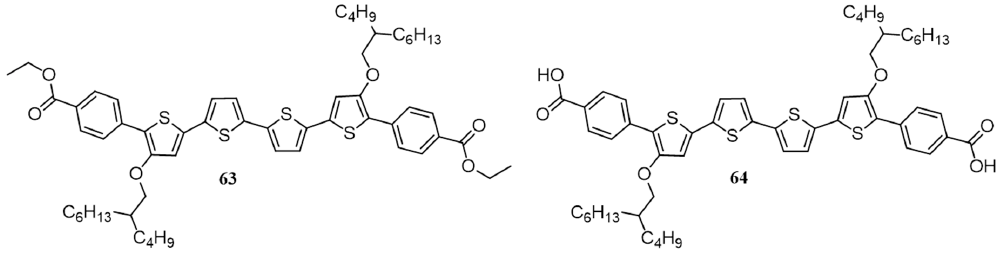
Figure 24. Chemical structures of the quarterthiophene core with diester ( 63 ) and diacid ( 64 ) end-groups, synthesized by Lam et al. [85].